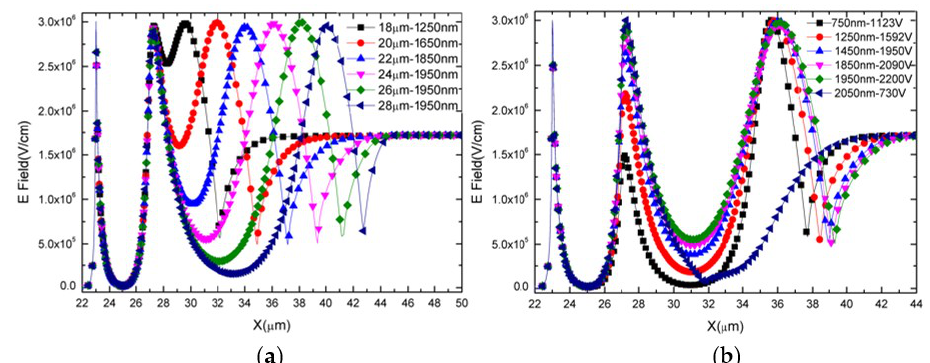
Figure 9. V BD as a function of t 2 and L FP-S .